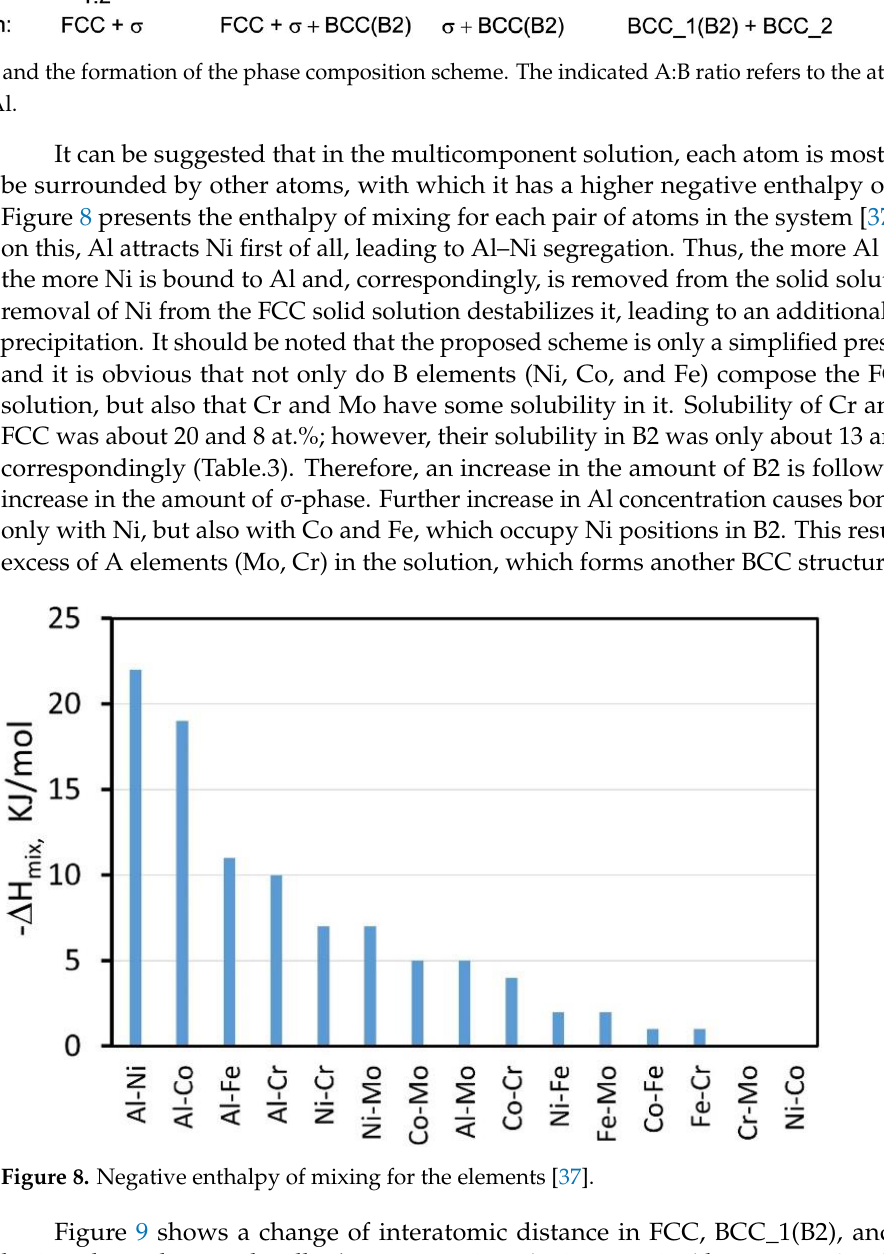
Figure 9. Change in the shortest interatomic distance in the crystal lattice of the solid solutions (FCC or BCC) in dependance of Al concentration in the alloy. The distance was calculated as ½ (110) for FCC and as ½ (111) for BCC lattices. In the alloys with an Al concentration higher than 8 at.%, the FCC lattice parameter decreased, which showed a change in the FCC solid solution composition. As we proposed earlier, at this Al content, Ni leaves the solid solution after being attracted to Al. It is known that Ni has the smallest atom radius among the other elements of this system,